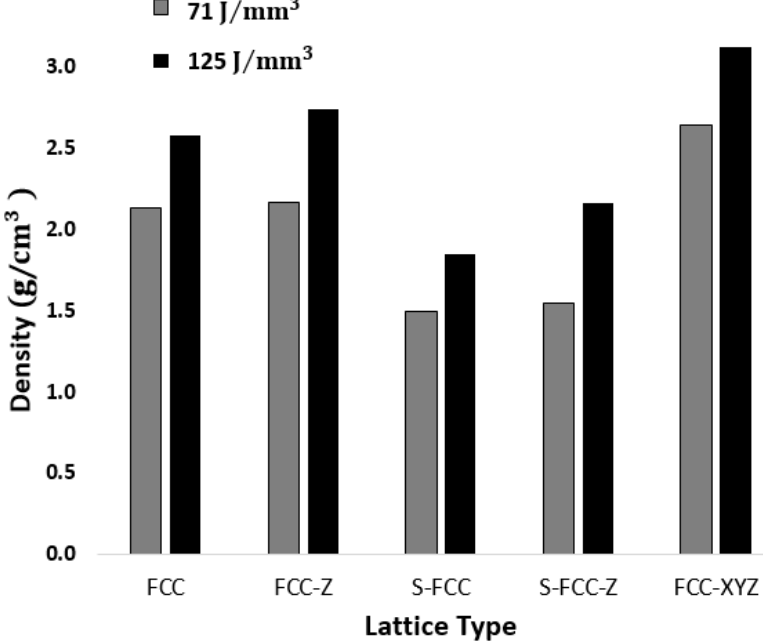
Figure 6. Density of built objects with varying lattice structures.